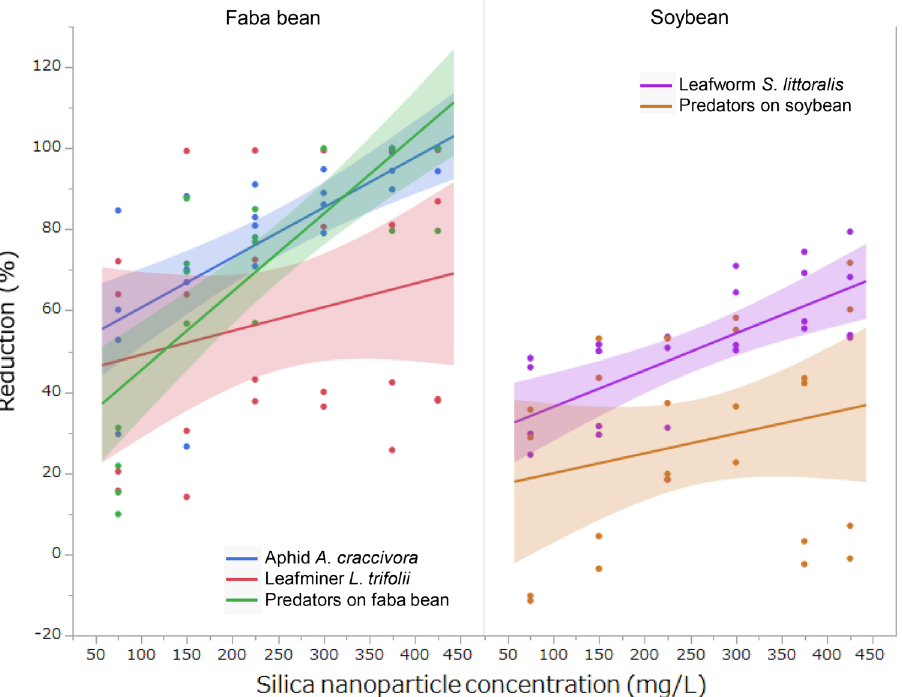
Figure 4. Relationship between silica (SiO 2 ) nanoparticle concentration and the reduction of pest and predator insects 1–3 days after spraying silica nanoparticles on either faba bean ( Vicia faba ) or soybean ( Glycine max ) in the field. Shaded area indicates 95% confidence